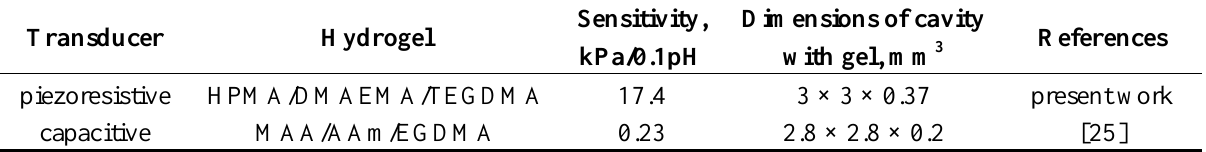
Table 5. Parameters of microfabricated implantable pH